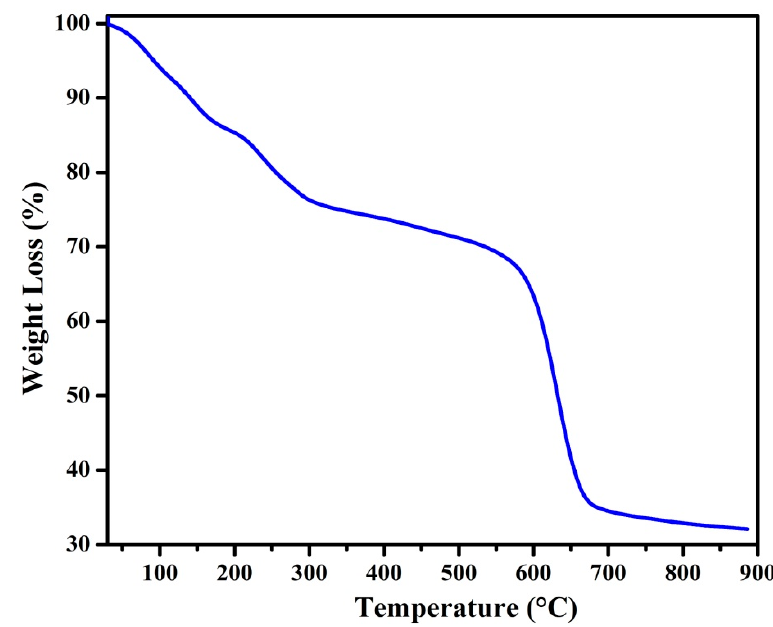
Figure 2. TGA curve of TU4.